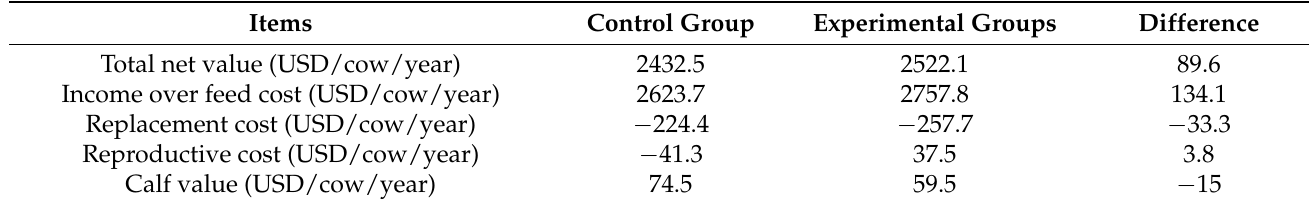
Table 2. Contribution to net